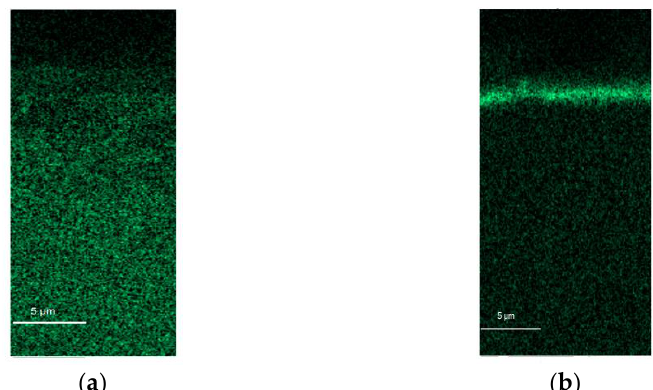
Figure 6. Elemental mapping of Ag in Ag2 ( a ) prior to and ( b ) and after heat treatment at the surface of samples.